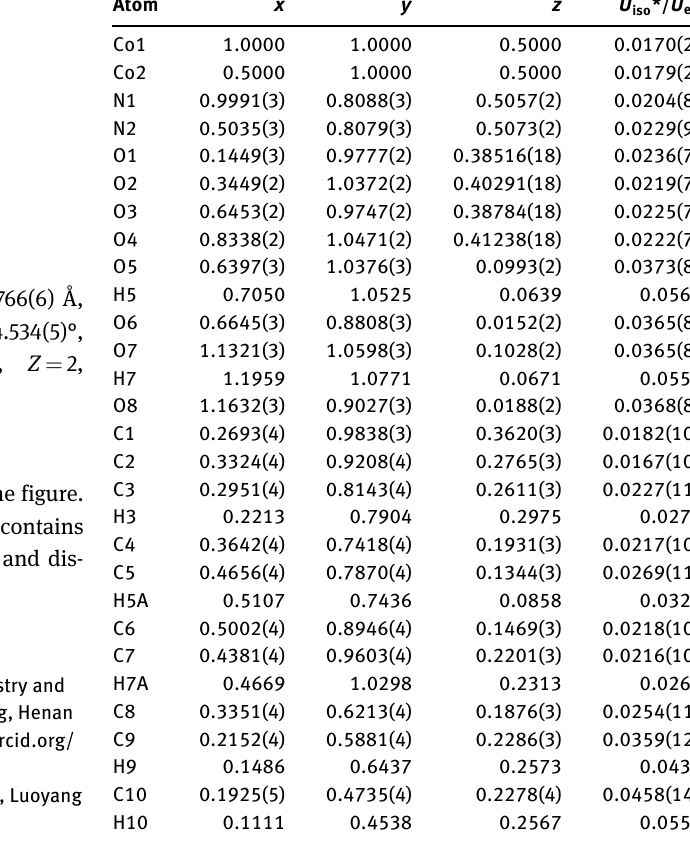
Table 2: Fractional atomic coordinates and isotropic or equivalent isotropic displacement parameters (Å 2